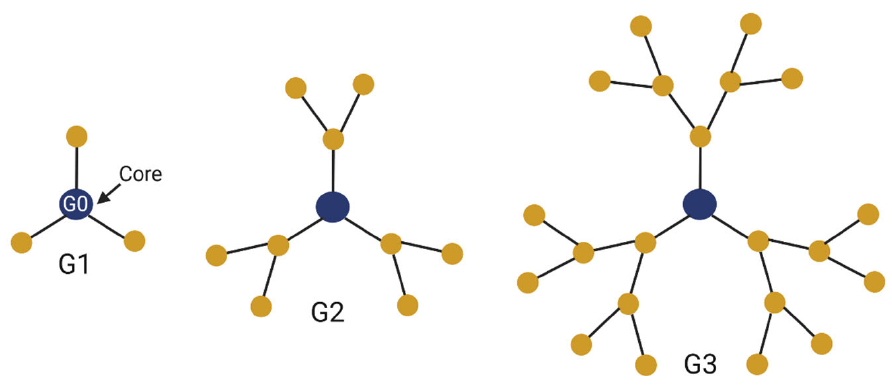
Figure 1. Schematics of dendrimers with one, two, and three generations. Each generation creates new moieties for attachment of functional ligands and therapeutics.